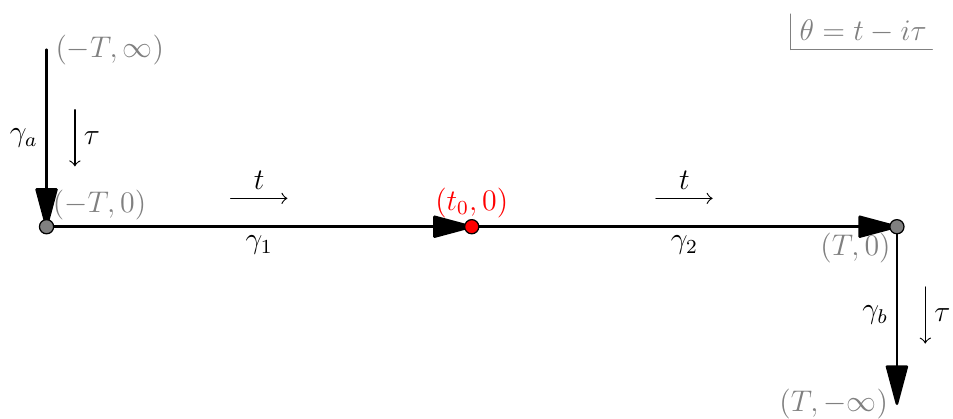
Figure 7. The in-out Schwinger-Keldysh contour appropriate for a transition between wormhole states. On the segments γ a and γ 1 the state is | λ i . Then at Lorentzian time t = t 0 a “heavy” operator is suddenly applied (red bullet on the diagram) that changes the state to | λ 0 i . This new state then forms that background on the segments γ 2 and γ b